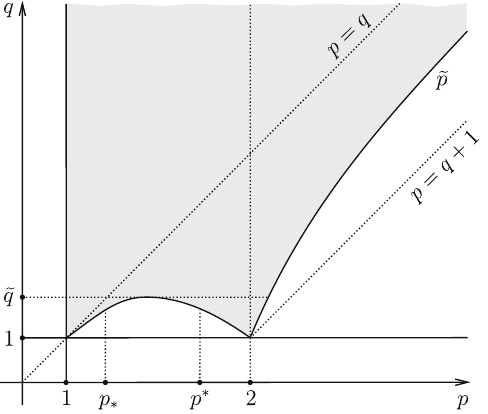
Figure 1: The grey set schematically depicts the set of points p q , ( ) with p I q ∈ ( )